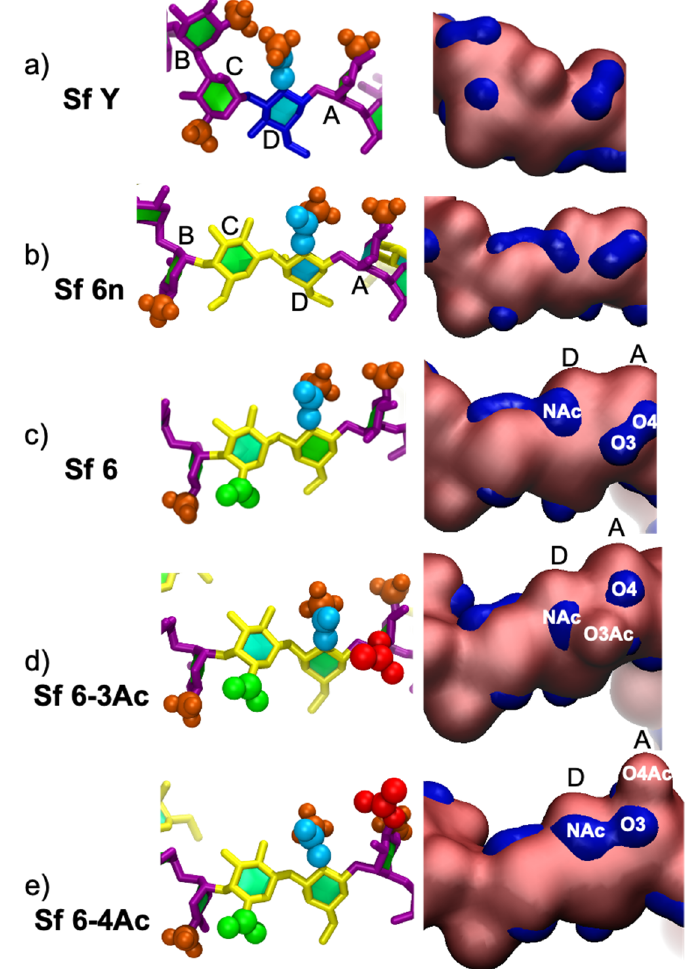
Figure 5. Close up of BCDA residues of RU3/4 in the licorice/paperchain/VDW and Quicksurf representations of the primary clusters of: ( a ) Sf Y, ( b ) Sf 6n, ( c ) Sf 6, ( d ) Sf 6-3Ac, and ( e ) Sf 6-4Ac O-antigens. The licorice/paperchain/VDW colors: purple- Rha; dark blue—Glc; yellow—Gal; green— COOH; red—O-acetyl; orange—Me; and cyan—electron withdrawing portion of NAc. The Quicksurf colors: blue—hydrophilic surface, pink—hydrophobic & neutral surface.